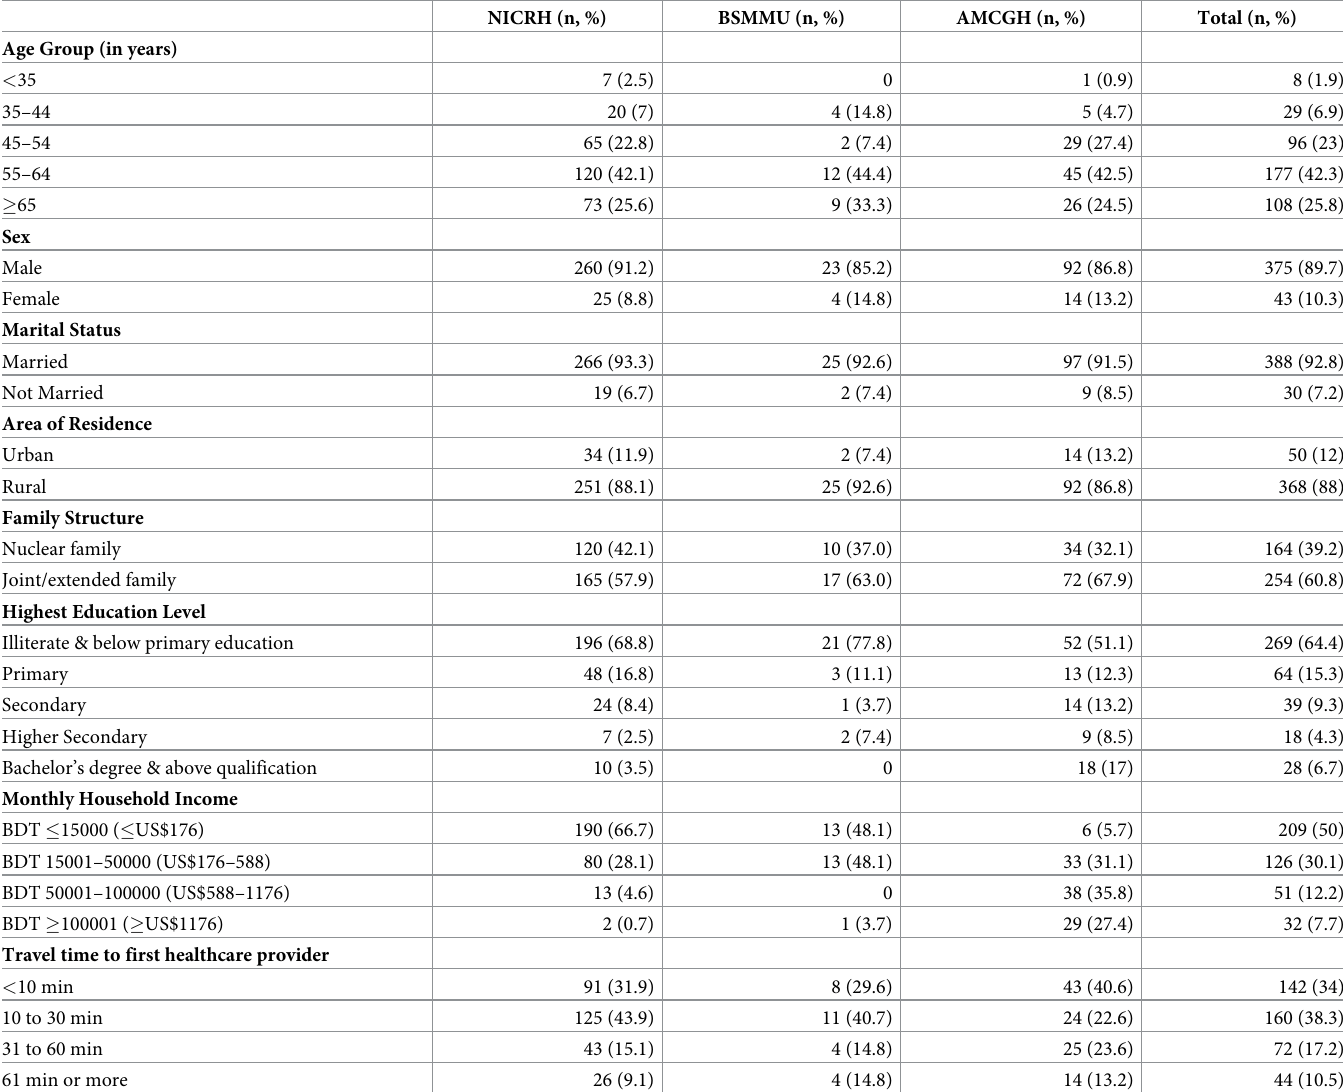
Table 1. Characteristics of the participants (n =